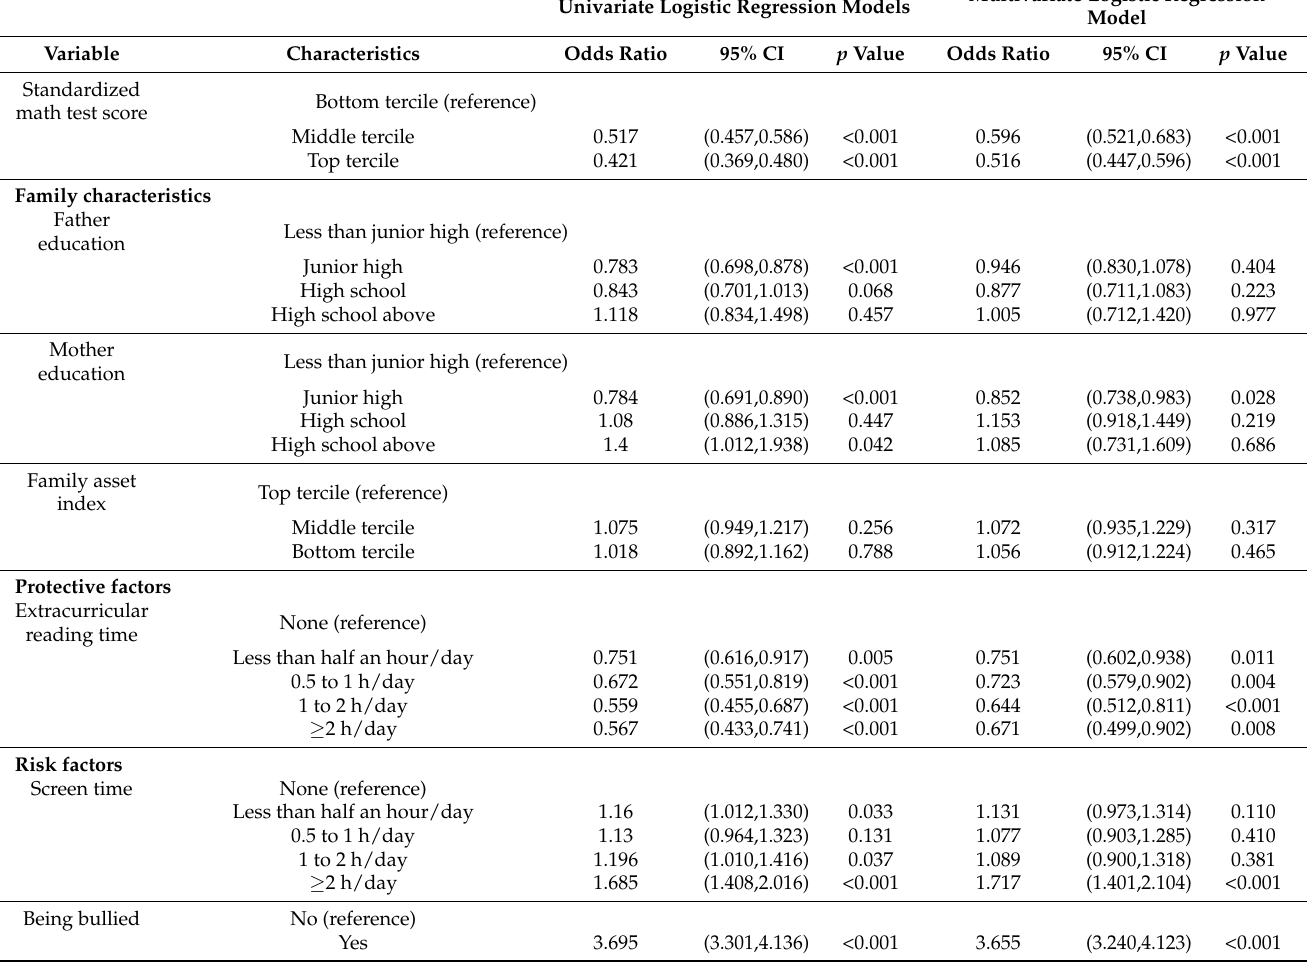
Table 3. Cont. Univariate Logistic Regression Models